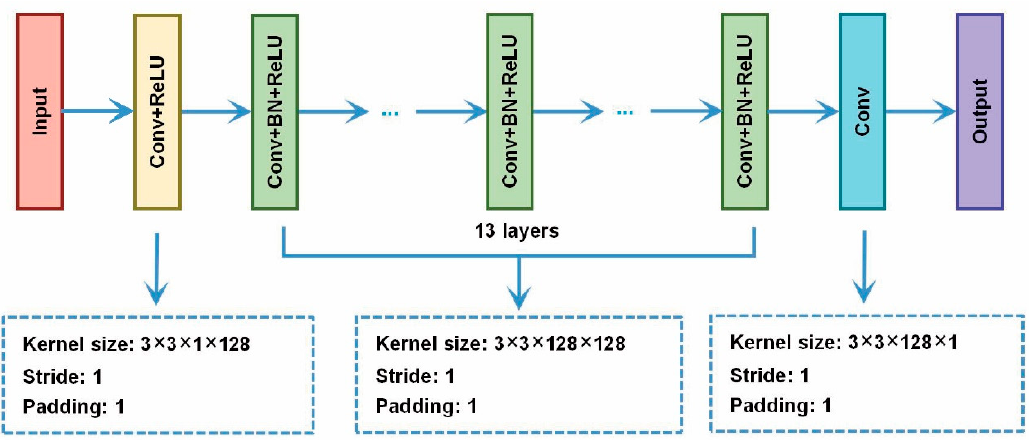
Figure 2. The framework of denoising convolutional neural network (CNN) [42,43].